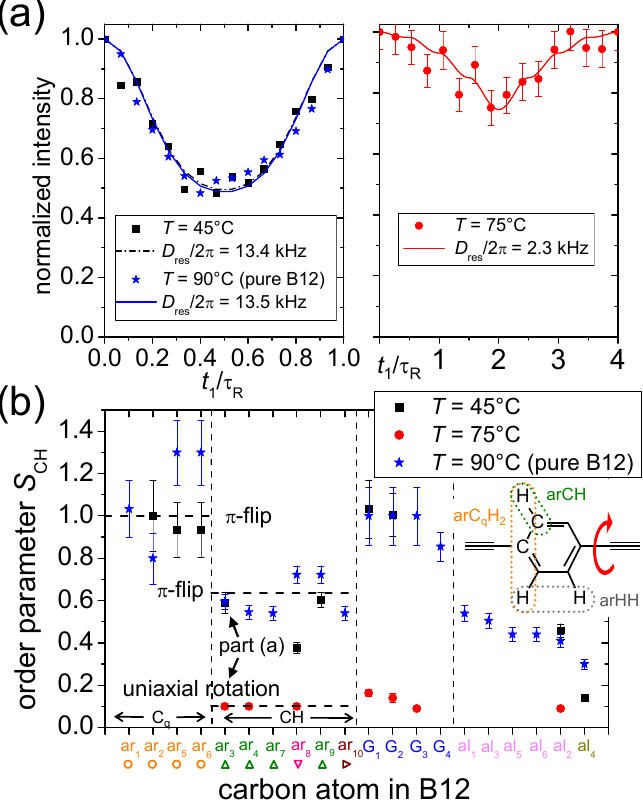
Figure 12. ( a ) 13 C– 1 H DIPSHIFT ( left ) and T 2 -recDIPSHIFT ( right ) dephasing curves for aromatic resonance ar 3 of B12 in a 1:4 mixture with DPPC; ( b ) S CH values for all resolved B12 resonances as well as expected values for specific motional models for B12 (dashed lines). The inset shows schematically the different dipolar tensors probed. See Figure 2 for resonance assignments of the B12 aromatic core. Figure reproduced with permission from ref. [23]. Copyright 2016 Americal Chemical